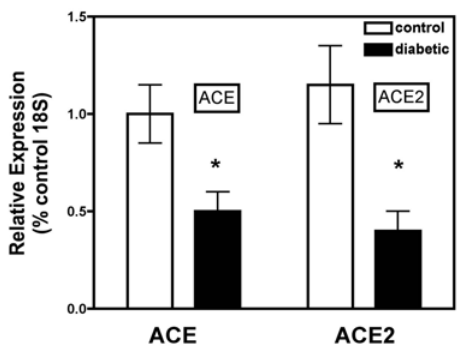
FIGURE 3 . Expression of ACE and ACE2 mRNA in control and diabetic rodent tubules (* p < 0.05 vs. controls).